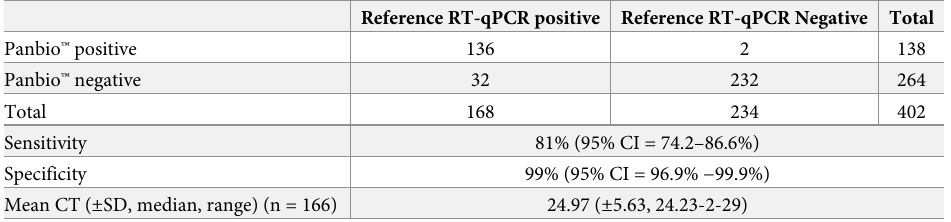
Table 1. Diagnostic performance of the Panbio ™ rapid antigen test in oropharyngeal